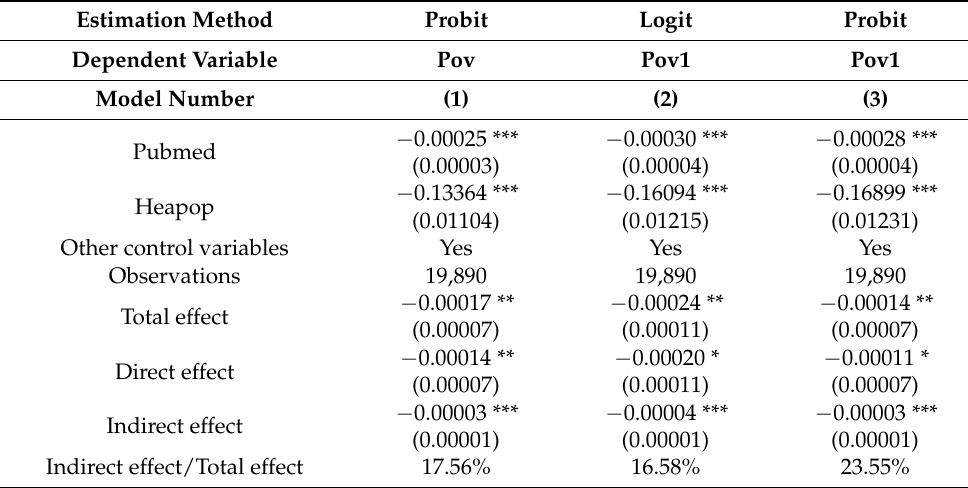
Table 5. Robustness test of public health services for poverty